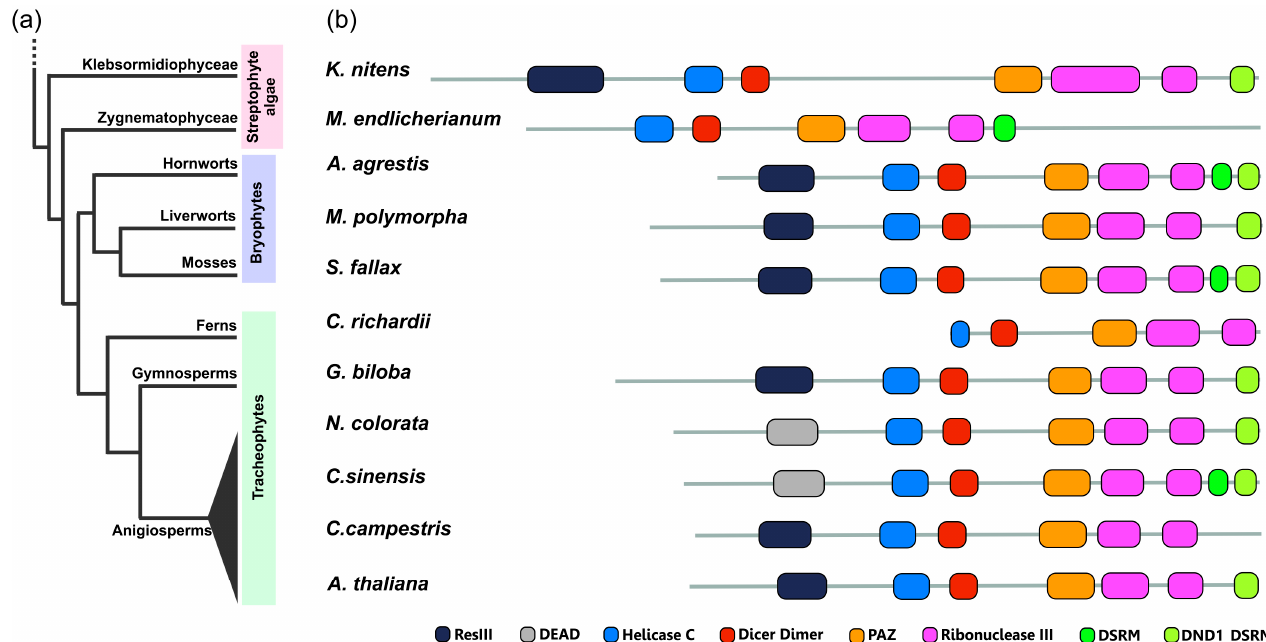
Figure 5. Conservation and divergence of DCL1 proteins across the plant kingdom. ( a ) Simpli- fied phylogenetic tree representing relationships among major groups of the Streptophyta lineage. ( b ) Differences in domain architecture between DCL1 proteins from different representatives of